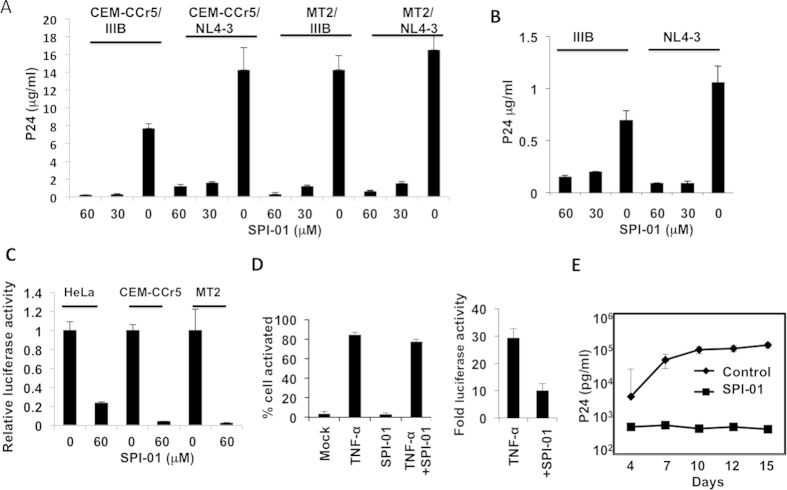
SPI-01 significantly reduces HIV-1 infectivity.(A) SPI-01 reduced, in a dose dependent manner, the infectivity of both HIV-1 NL4-3 and IIIB strains grown in CEM-CCR5 and MT2 cells. Cells were infected with the viruses for 16 h, and then excess virus and SPI-01 was washed away. Then cells were cultured for 7 days in media without the inhibitor, after which supernatants were collected and p24 levels measured by ELISA. (B) HIV-1 NL4-3 or IIIB strain obtained from the media after 7-day culture as described in (A) produced in MT2 cells treated with 60 μM SPI-01 or mock treated were normalized by p24 level and then tested for infectivity in uninfected MT2 cells. Infection was detected by p24 levels in the media after 7 days. (C) Pseudovirus produced in HeLa cells treated with 60 μM SPI-01 or mock treated were tested for infectivity in different cells. Infection was detected by luciferase activity from HIV encoding luciferase. (D) Effect of SPI-01 on activation of latent HIV-1. SPI-01 did not affect activation of latent HIV-1 by TNF-α(left panel). Infectivity of HIV-1 generated from SPI-01-treated latency cells (U1/HIV-1), when activated by TNF-α, is reduced (right panel). (E) Viral replication in CD8-depleted PBMCs challenged with the NL4-3 strain of HIV-1 (MOI of 0.01) in the presence or absence (control) of 50 μM SPI-01. Viral replication was assayed based on HIV-1 p24 ELISA on days 4, 7, 10, 12, and 15 post-infection. Error bars represent standard deviation of experiments performed in triplicate.